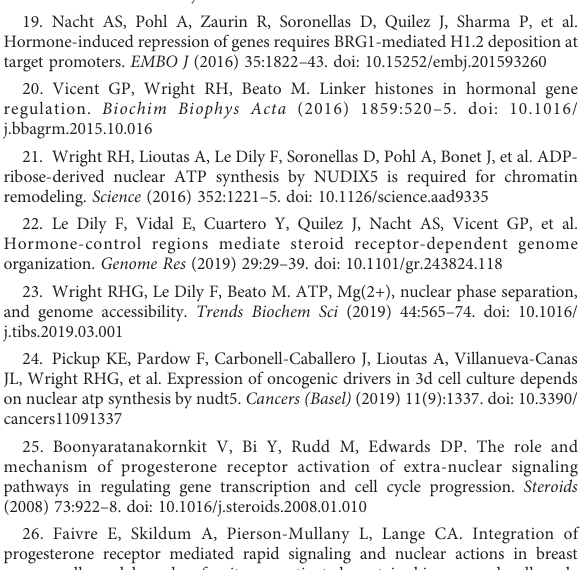
node represents and individual protein and interactions are represented by edges. Functional analysis was carried out to identify key pathways